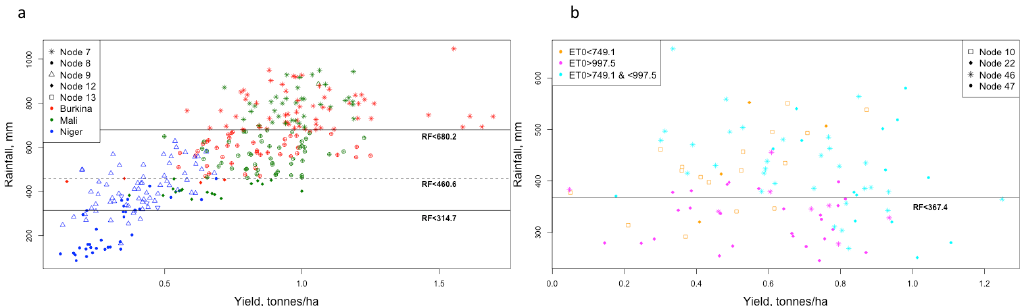
Figure 12. ( a ) The regression tree results for Burkina Faso, Mali, and Niger with yield plotted against precipitation; the different dot shapes represent the nodes the observation is under and the different dot colors represent the country the observation is from, with lines representing the regression tree rules for precipitation. The first rule for Burkina Faso and Mali data is precipitation greater (less) than 680.6 mm, and the second rule is precipitation greater (less) than 460.2 mm. The rule for Niger observations is precipitation greater (less) than 314.7 mm. ( b ) The regression tree results for Senegal with yield plotted against precipitation, the different dot shapes representing the node the observation is under and the different dot color representing the ET 0 rules, with a line representing the rule for precipitation. The first rule splits data into greater than 749.1 mm and less than 749.1 mm (represented in orange). The second rule splits data into greater (less) than 997.5 mm, with data that is greater than 997.5 represented in pink. The data that falls between 997.5 mm of ET 0 and 749.1 mm are represented in blue, and are subject to the precipitation rule of greater (less) than 367.4 mm.